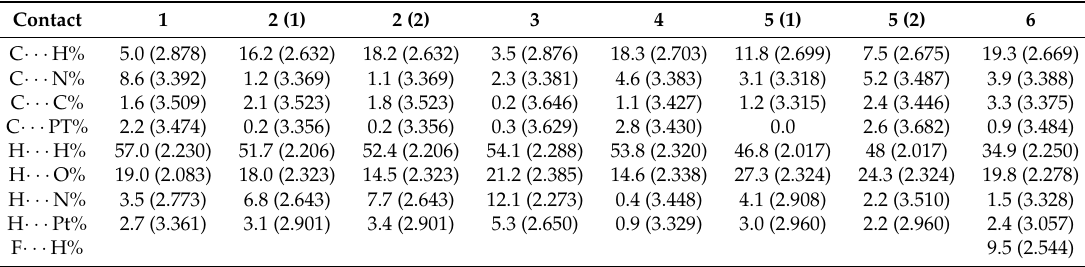
Table 1. Summary of the most important intermolecular contacts and their percentage contributions in the crystal structure of the studied complexes. The minimum contact distances are in angstroms.